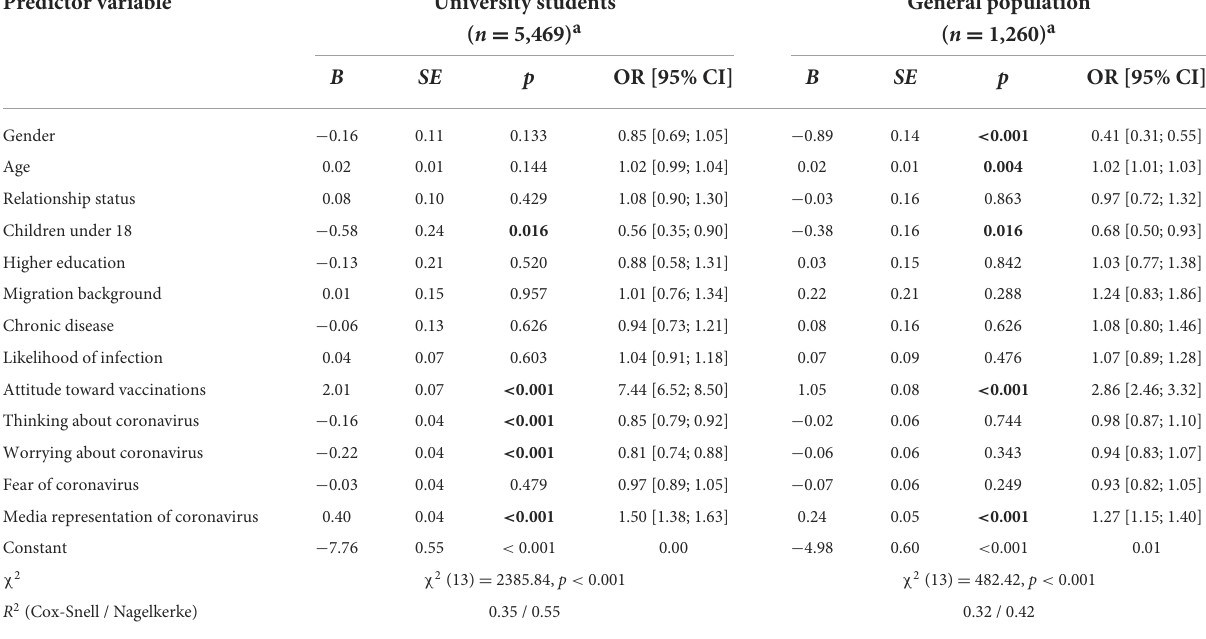
TABLE 4 Predictors of vaccination intention in university students and the general